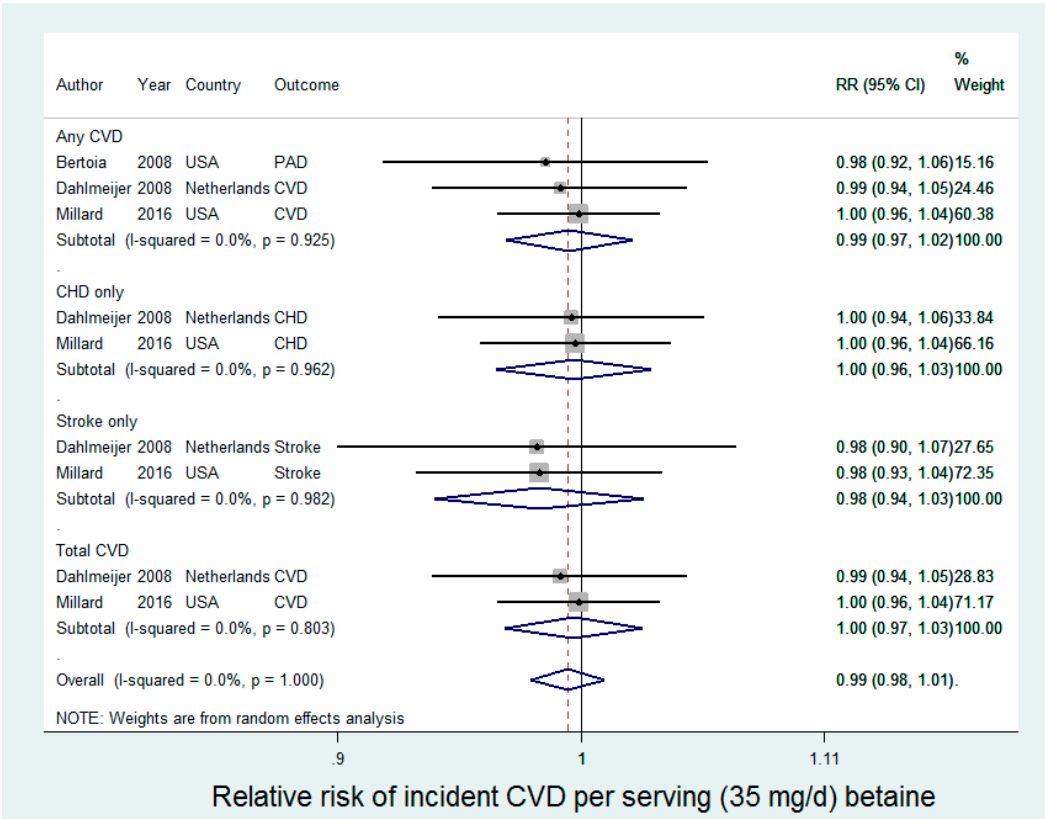
Figure 2. Betaine intake and CVD incidence.